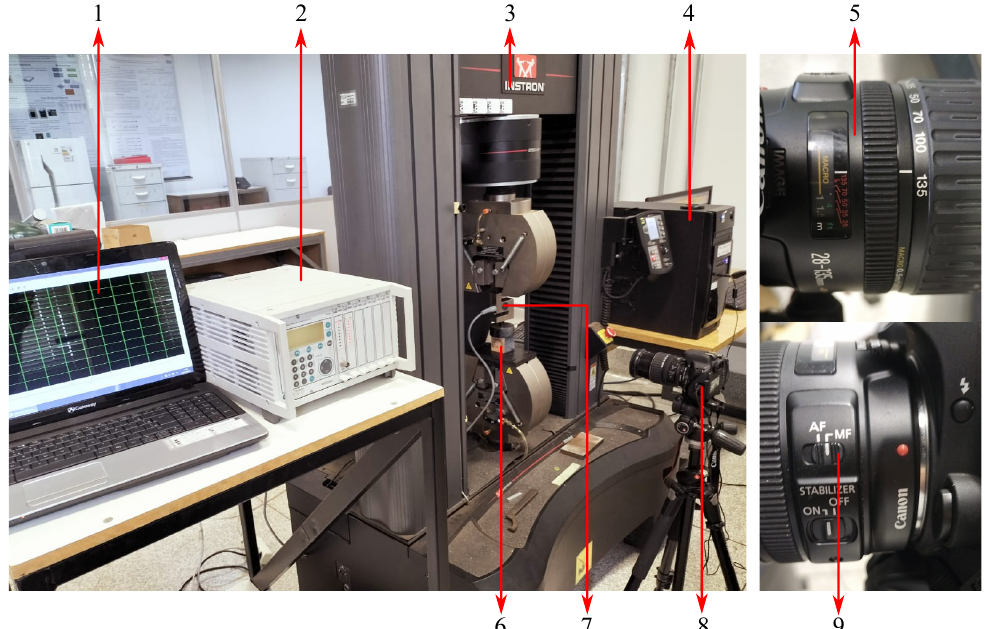
Figure 4. Setup applied for the compression tests labeled as follows: 1. MGCplus Assistant software to show the strength data acquired from the HBM. 2. HBM MGCplus AB22A data acquisition system connected to the load cell. 3. Instron UTM 5985 controlling the test speed. 4. Computer controlling the UTM by the Bluehill software and the camera by the software EOS Utility Version 3 (2015). 5. Canon Macro lens model EF 28–135 mm IS with minimal focal distance of 0.5 m. 6. Test specimen. 7. 20 kN Load cell from Vicere model ST2K. 8. Canon EOS Rebel T6i placed 0.55 m from the sample on a tripod stand. 9. The focus was set to manual to optimize the